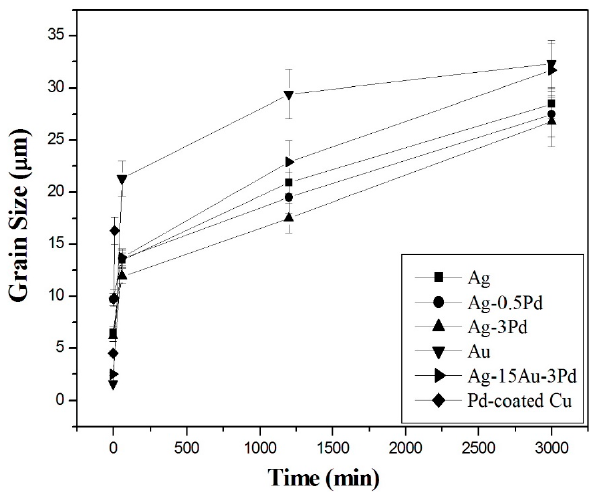
Figure 8. Variations of the grain sizes of bonding wires after current stressing at 1.23 × 10 5 A/cm 2 for various times.